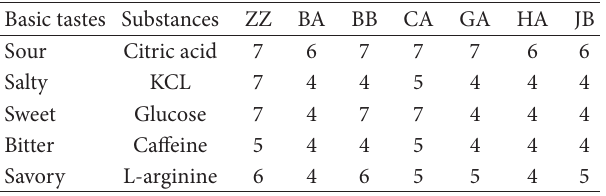
Table 1: Sensor sensitivity (pC) of ASTREE electronic tongue